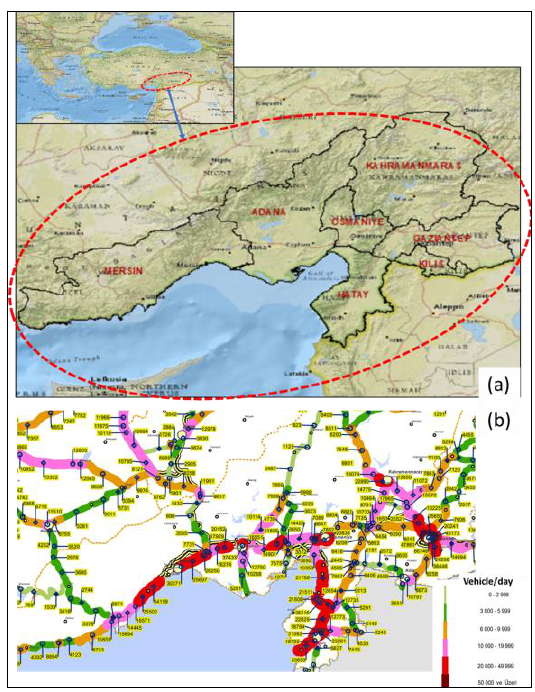
Figure 1. Mersin Region (a) cities and (b) traffic volumes